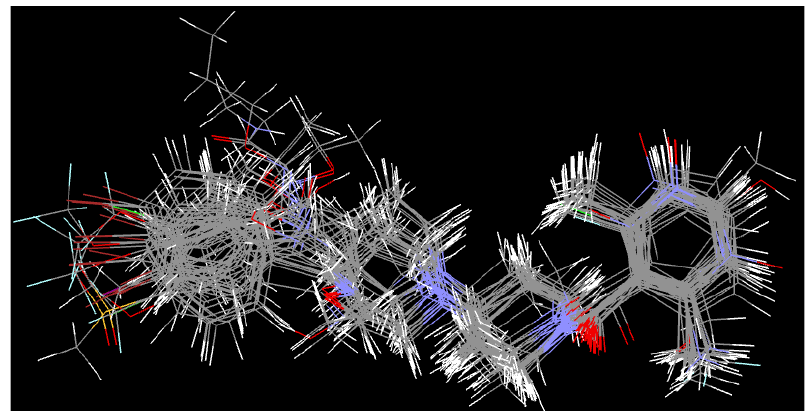
Figure 4. Molecular alignments used in the present study.